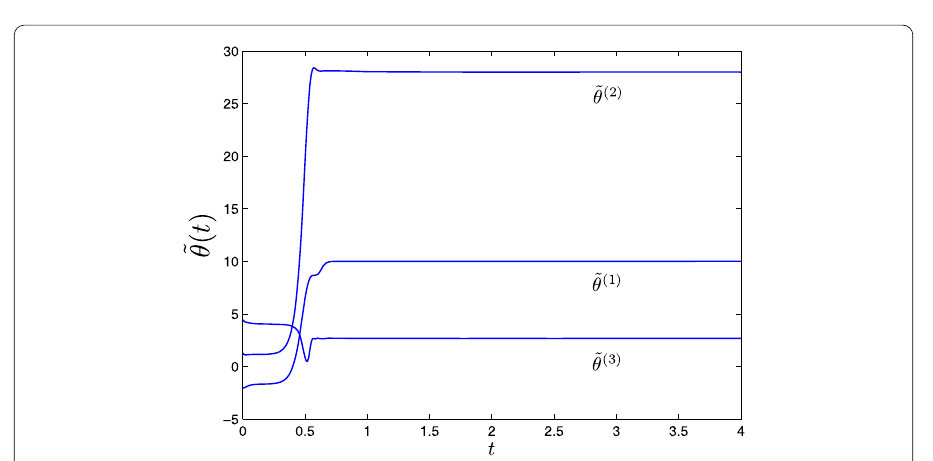
˜ θ ˜ θ (1) ˜ θ (2) ˜ θ (3) = ( , , ) T by linear feedback control with